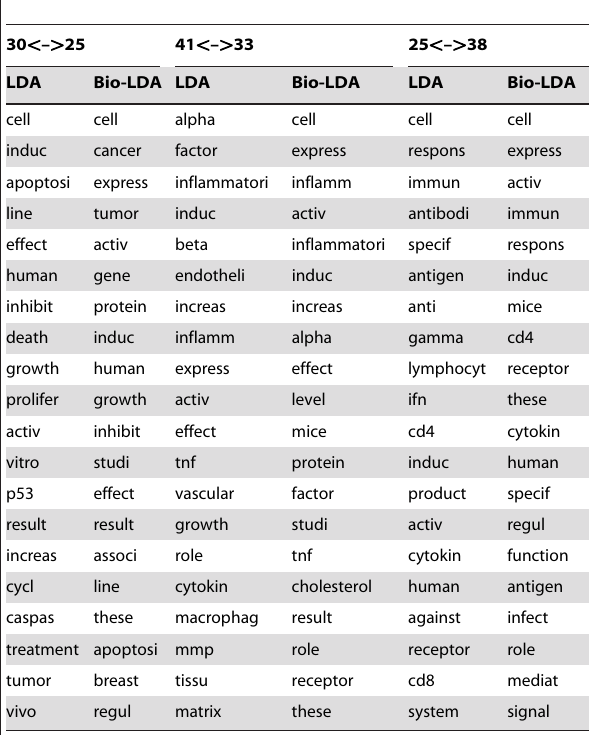
topics. The colors of lines are used to present various topics. Solid lines indicate the generated relationships are proofed by Chem2Bio2RDF (i.e. there is a relationship in one of the Chem2Bio2RDF datasets that confirms the literature relationship). The dashed lines indicates the generated relationships have not been found in Chem2Bio2Rdf, perhaps indicating very recent findings which are not yet encoded in databases, or associations Table 5. Compare word representation of topics in the Bio- LDA model to topics in the LDA model.